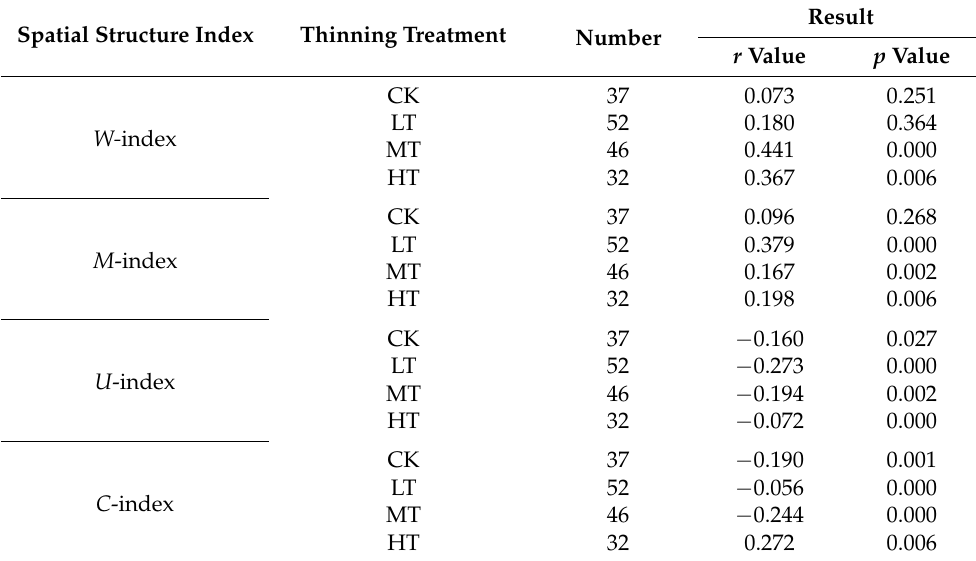
Table 3. The correlation analysis of spatial structure index and carbon